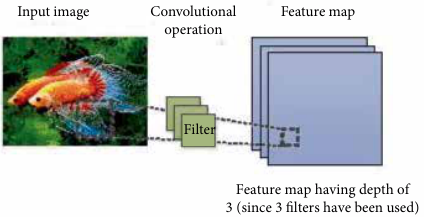
Figure 4: Feature extractor using convolutional operation.